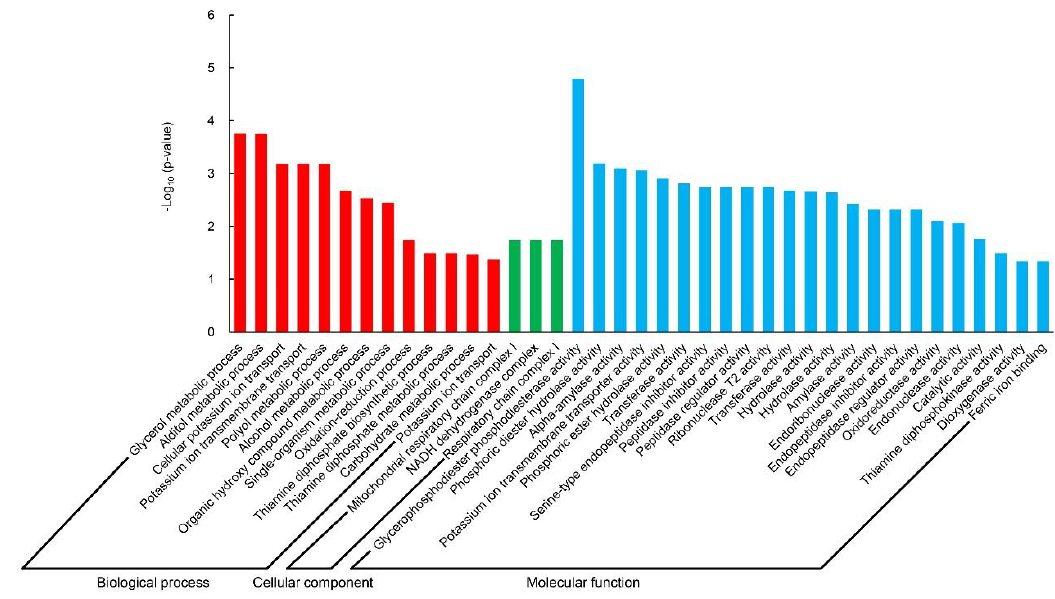
Figure 2. Significantly enriched Gene Ontology (GO) terms ( p < 0.05) analysis in B36 vs. A36. B36 vs. A36: Samples (seeds and seedlings) under N240 compared to those under N0 at 36 HAI. Table 2. List of selected genes for dioxygenase activity that were differentially expressed in EB36 vs.